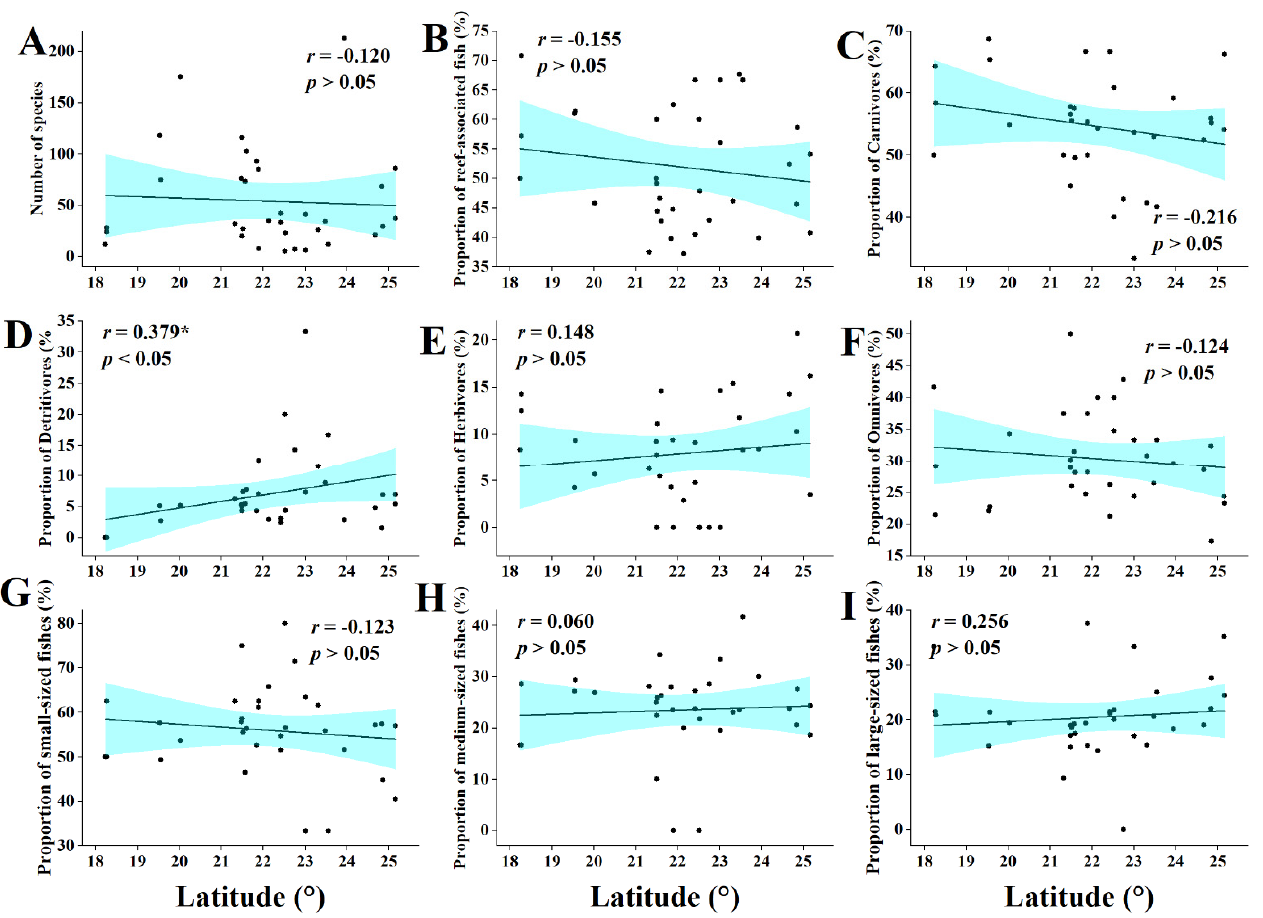
Figure 7. Relationship between mangrove latitude and characteristics of fish communities. ( A ) The relationship between number of fish species and the mangrove latitude. ( B ) The relationship between reef-associated fish and the mangrove latitude. ( C ) The relationship between carnivores and the mangrove latitude. ( D ) The relationship between detritivores and the mangrove latitude. ( E ) The relationship between herbivores and the mangrove latitude. ( F ) The relationship between omnivores and the mangrove latitude. ( G ) The relationship between small-sized fishes and the mangrove latitude. (H) The relationship between medium-sized fishes and the mangrove latitude. (I) The relationship between large-sized fishes and the mangrove latitude. (**: Extremely Significant, p < 0.01. *: Significant, p < 0.05).